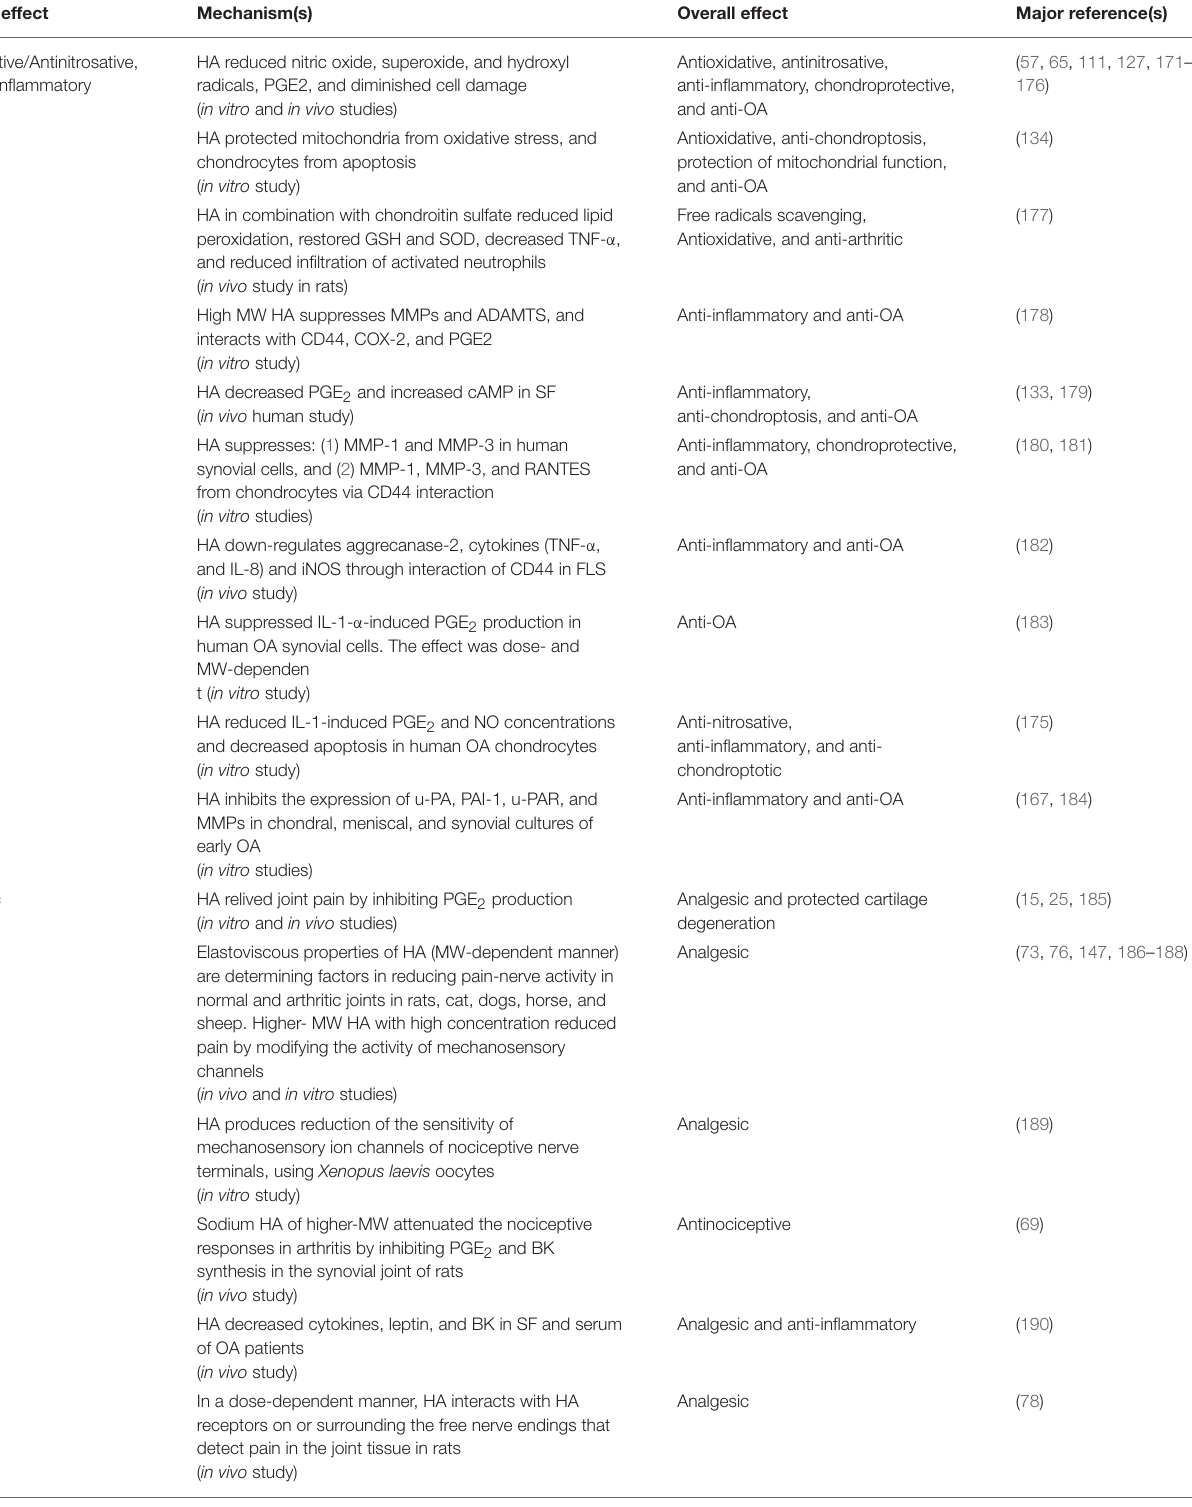
TABLE 2 | Mechanisms-based anti-OA effects of HA (some important